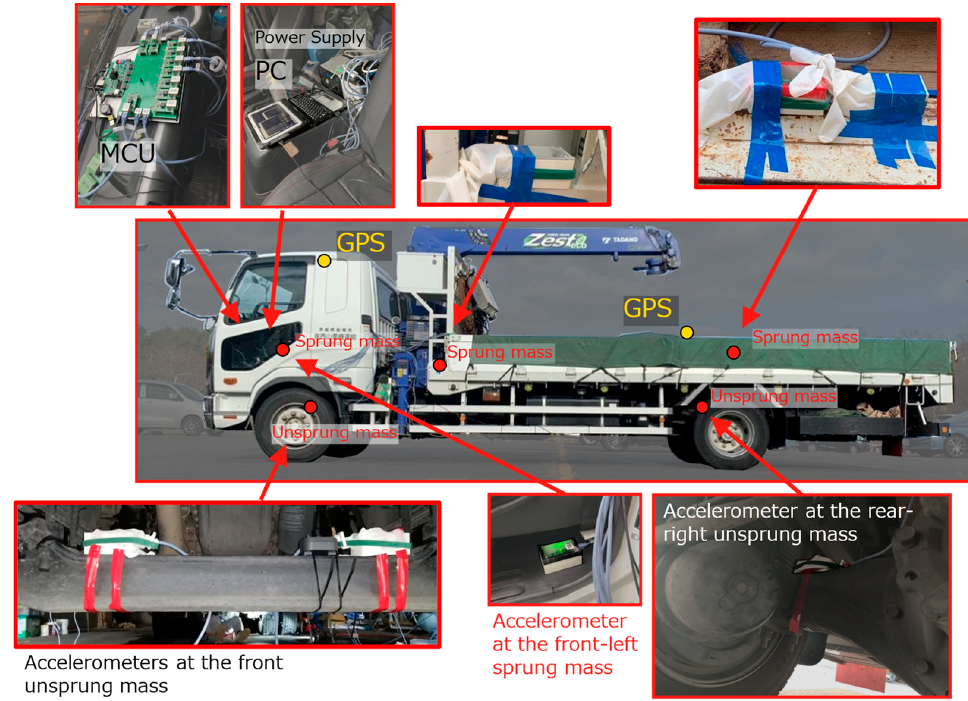
Figure 1. Vehicle and Accelerometers installation point.